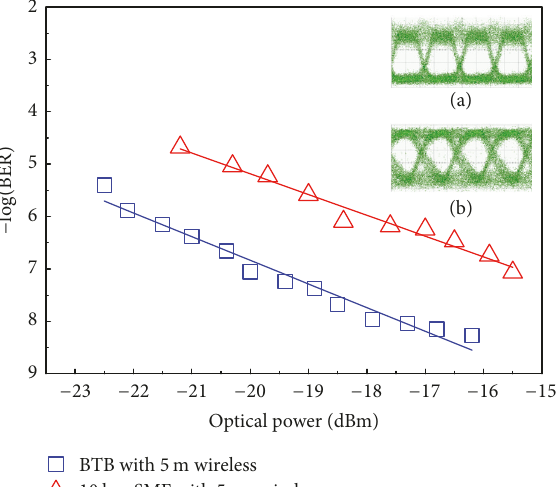
Figure 9: The measured BER curves of 2Gb/s signal, insert eye diagrams of signals (a) after 5 m wireless transmission without fiber, and (b) after 10 km fiber and 5m